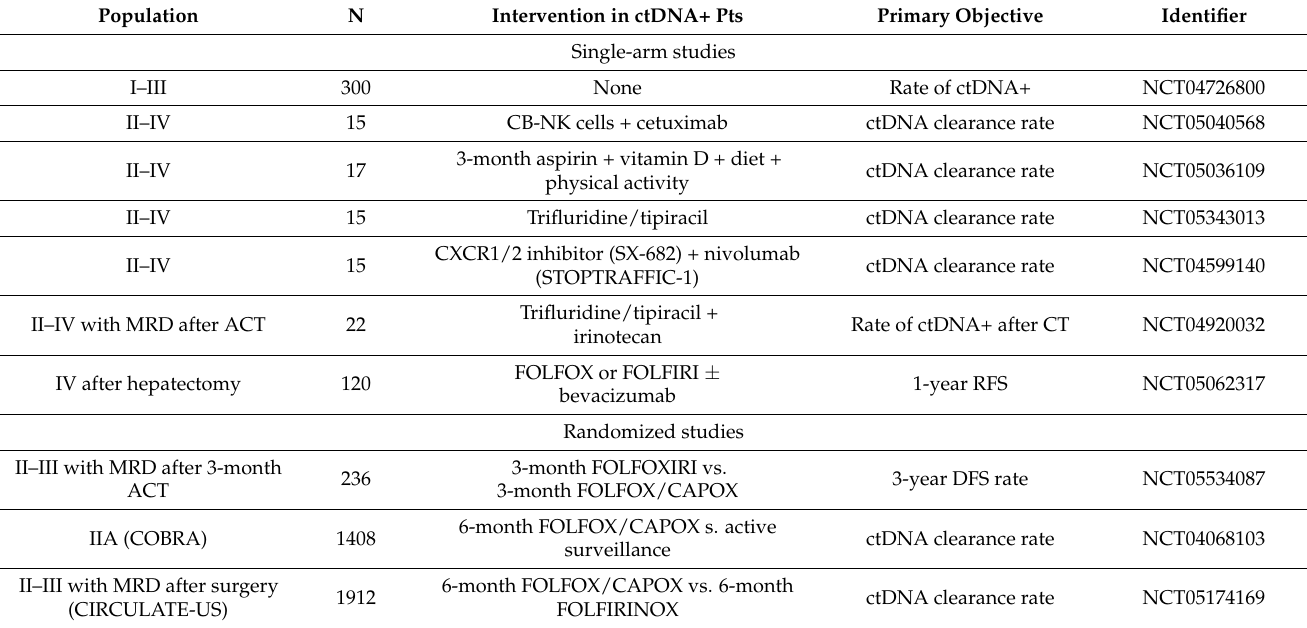
Table 2. Ongoing clinical trials evaluating the clinical applicability of ctDNA as MRD in colorec- tal cancer